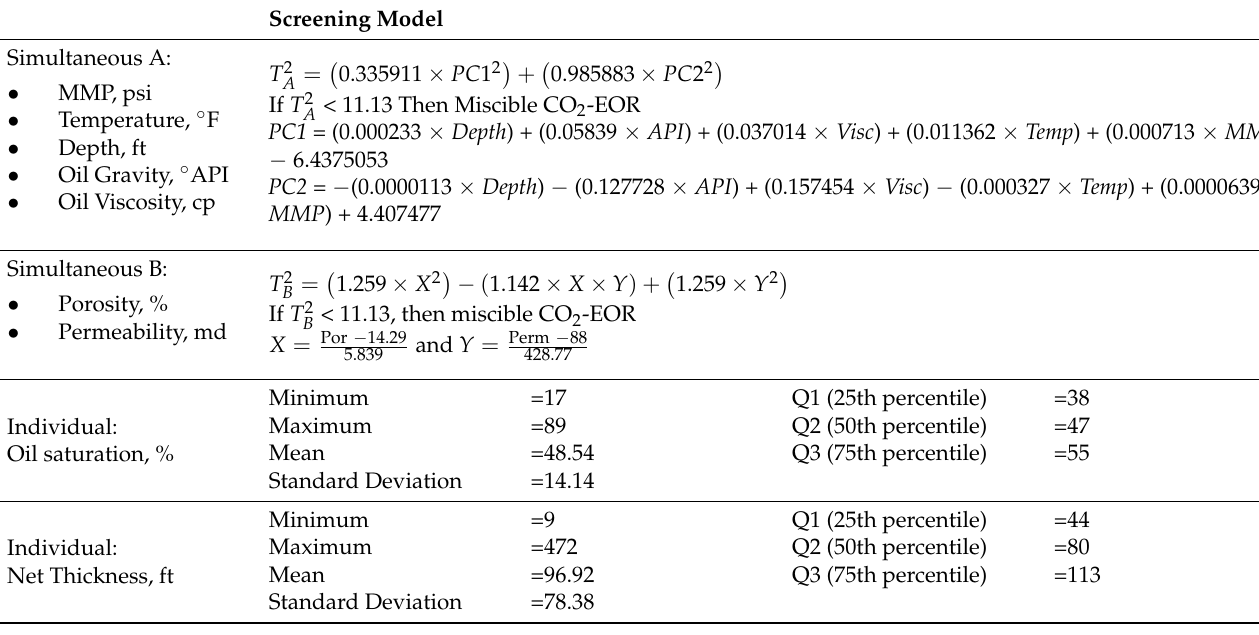
Table 3. Summary of the miscible CO 2 -EOR screening model. Screening